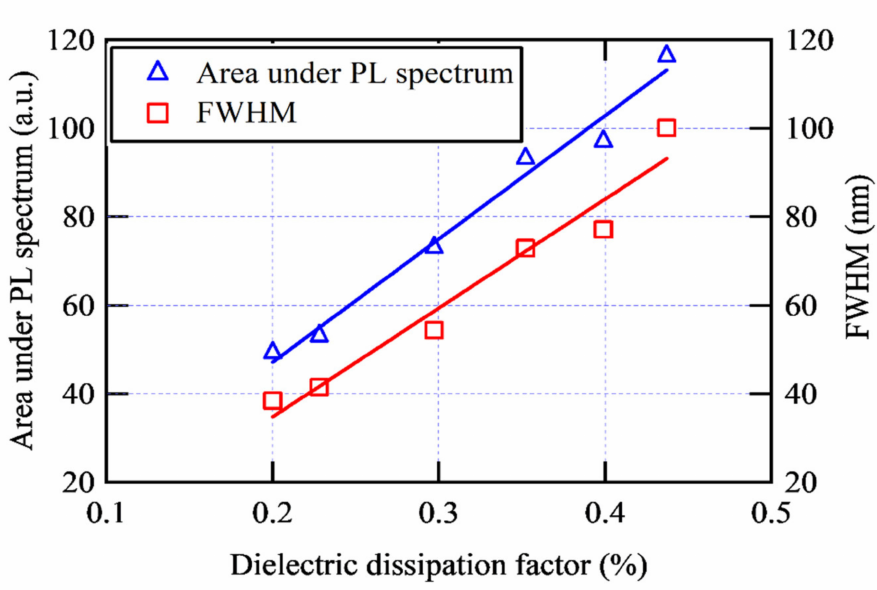
Figure 6. Correlation of FWHM and A PL deduced from PL spectra with DDF.